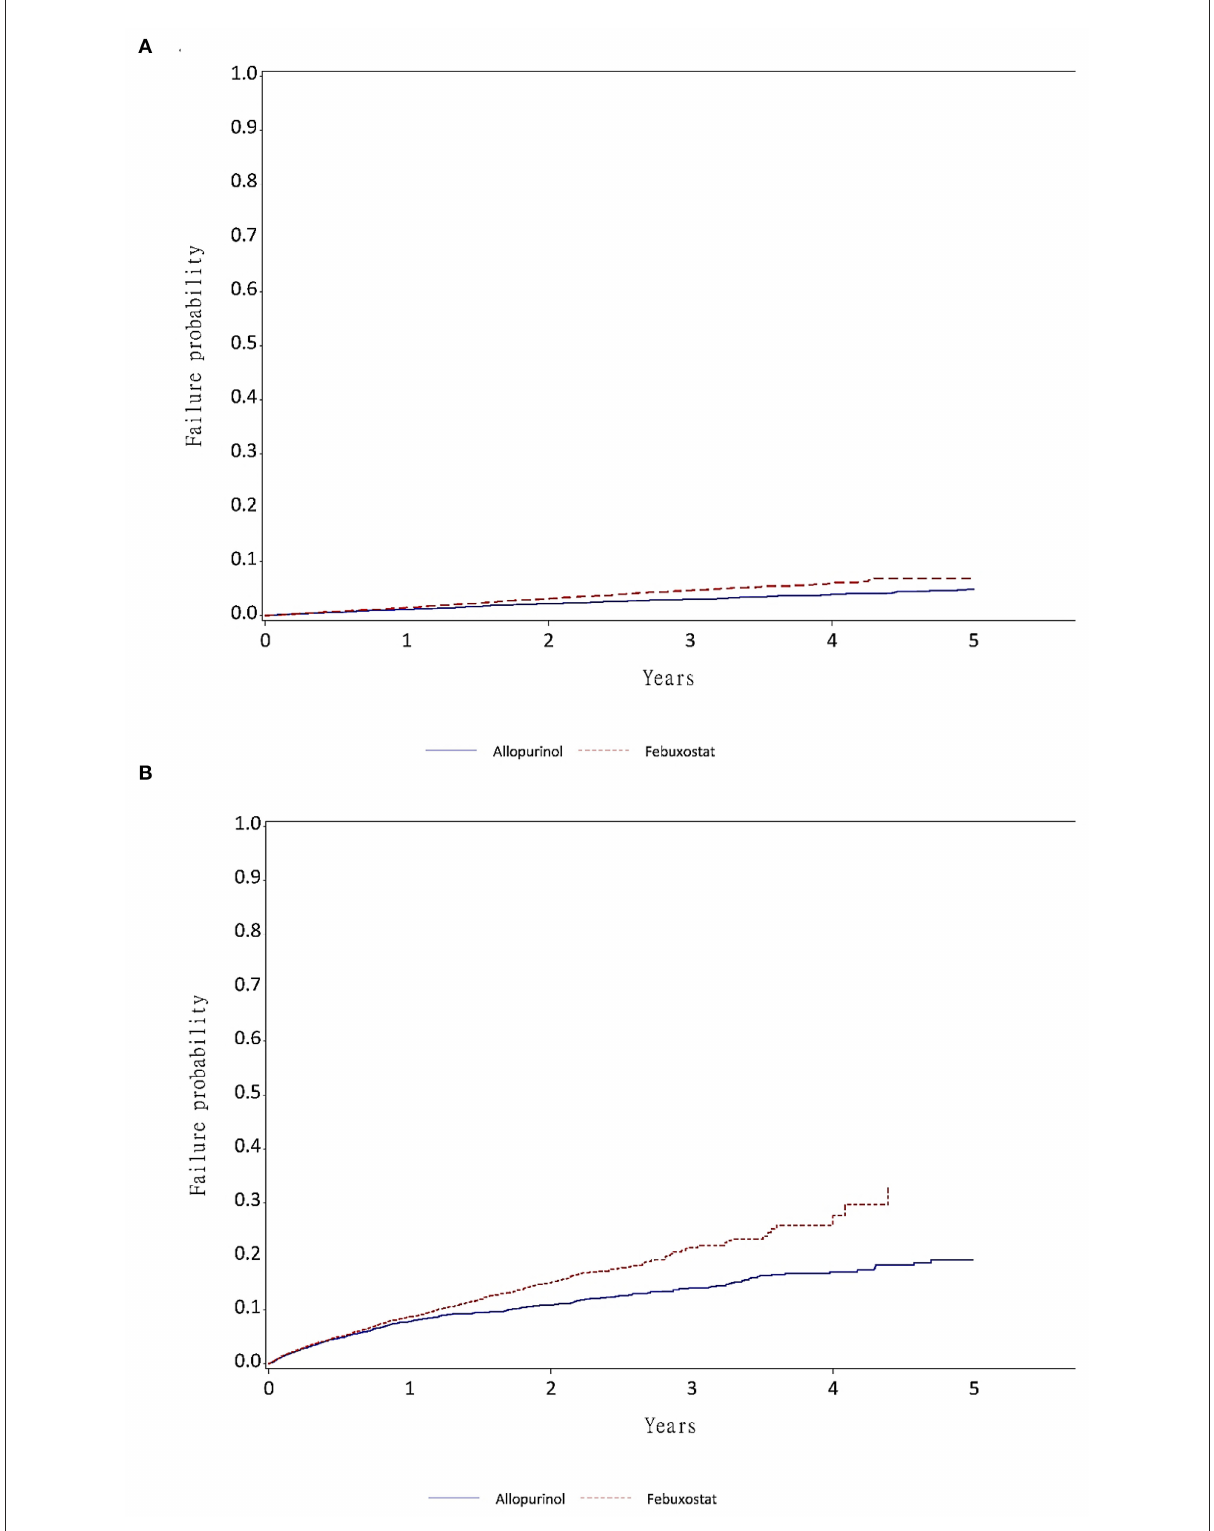
FIGURE3 The failure function by year of medication exposure. (A) Failure function of time to heart failure in patients without admission for AMI, HF, or stroke prior to the 3-year look-back period (low CV risk group). (B) Failure function of time to heart failure in patients admitted for AMI, HF, or stroke prior to the 3-year look-back period (high CV risk